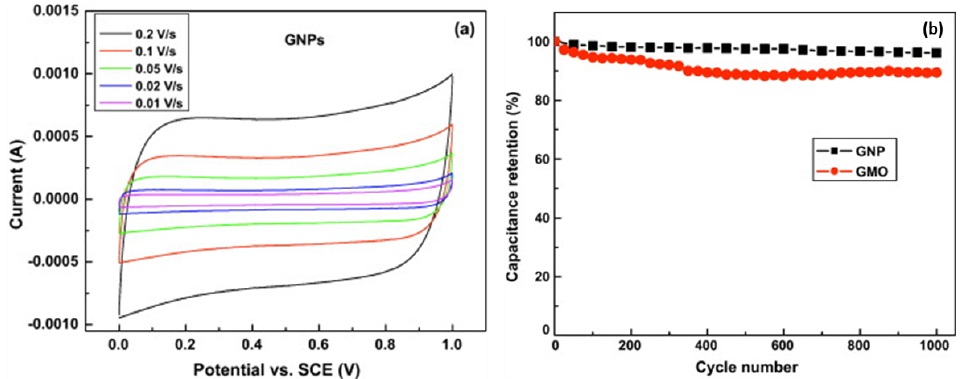
Figure 11. ( a ) Cyclic voltammetry results of GNPs at various scan rates in 2 M KCl aqueous electrolyte, and ( b ) Variation of the specific capacitance of GNP and GMO (MnO 2 -GNP) from cyclic voltammetry at scan rate of 400 mV/s in 2 M KCl aqueous electrolyte. Adapted with permission from Ref. [52]. 2011,